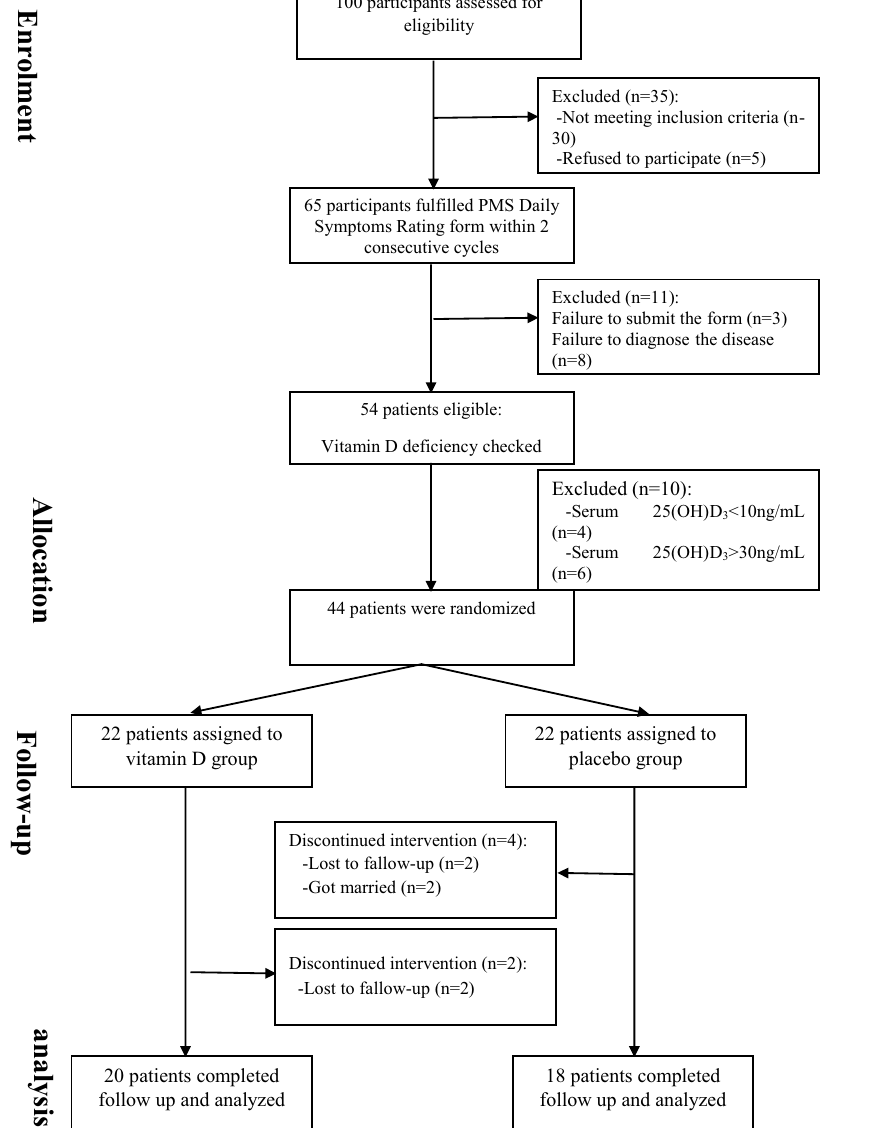
Figure 1. Flowchart of the participants through the